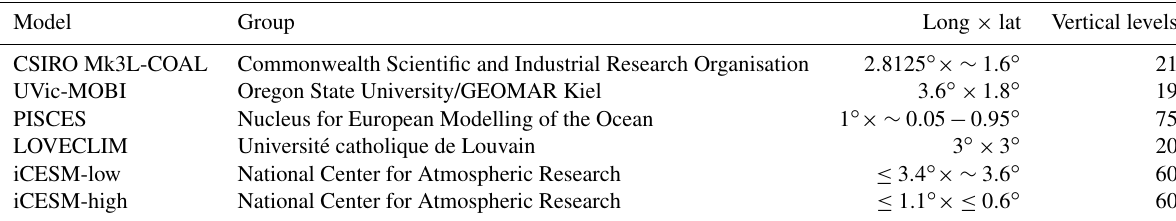
Table 1. Models assessed against isotope data. The University of Victoria – Model of Ocean Biogeochemistry and Isotopes (UVic-MOBI) fields taken from Schmittner and Somes (2016). Pelagic Interactions Scheme for Carbon and Ecosystem Studies (PISCES) fields provided by Laurent Bopp. LOch–Vecode-Ecbilt-CLio-agIsm Model (LOVECLIM) fields taken from Menviel et al. (2017a). The isotope-enabled Community Earth System Model (iCESM) fields for δ 13 C (low resolution) provided by Alexandra Jahn (Jahn et al., 2015) and those for δ 15 N (high resolution) provided by Simon Yang (Yang and Gruber, 2016). PISCES and CESM model resolutions have a range of longitude– latitude spacings to reflect regions of finer resolution, including the Equator and polar regions.